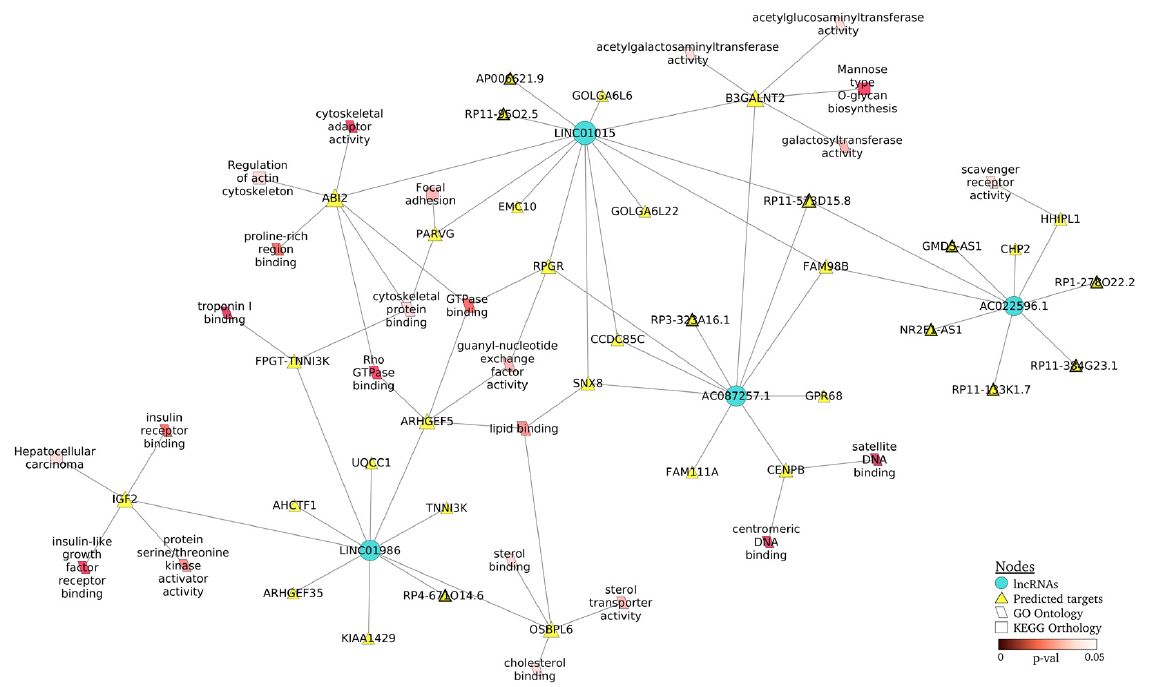
Figure 5. Regulatory network of lncRNAs–mRNAs for exosomal fraction in LN. The four lncRNAs (LINC01986, AC087257.1, AC022596.1 and LINC01015) represented as blue circles and their predicted targeted genes (yellow triangles) are shown, together with the top GO terms (parallelogram) and KEGG pathways (rectangle) whose color is proportional to the p value. Yellow triangles with bold border are lncRNAs as targets.